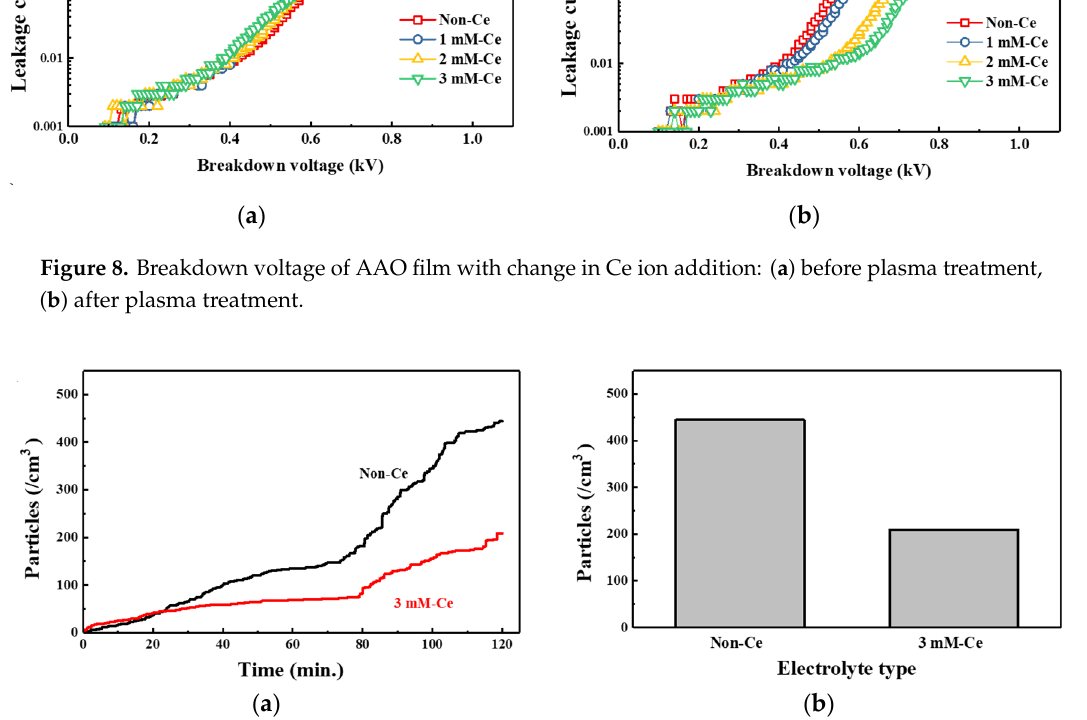
Figure 9. Generated contamination particles with exposure to CF 4 /Ar/O 2 plasma: ( a ) in-situ generated contamination particles, ( b ) total number of generated contamination particles after 2 h.